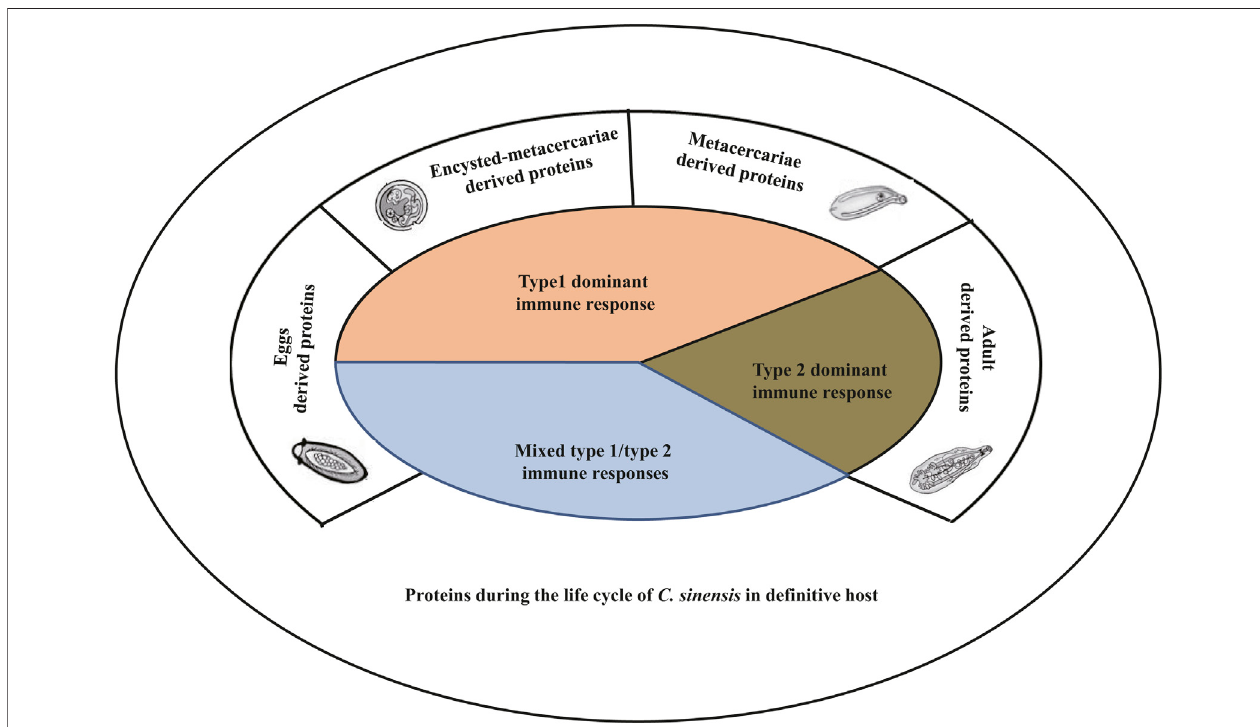
FIGURE 2 | The type of immune responses targeted by Clonorchis sinensis components during the life cycle of the parasite within its de fi nitive hosts. During its life cycle in its de fi nitive host, C. sinensis produces different types of compounds leading to the activation of either type 1 immune response or type 2 immune response, or both. Typically, proteins excreted by the juvenile stages (encysted-metacercariae and metacercariae) trigger type 1 immune response, while adult parasites secrete compounds that lead to the production of type 2 immune response rather than type 1. Eggs derived proteins generally activate both type 1 and type 2 immune